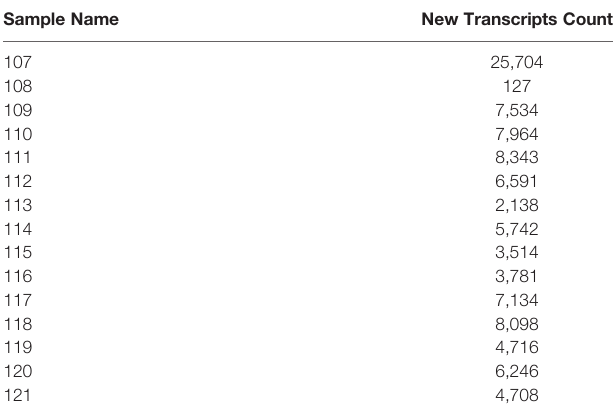
TABLE 3 | The counts of new transcript